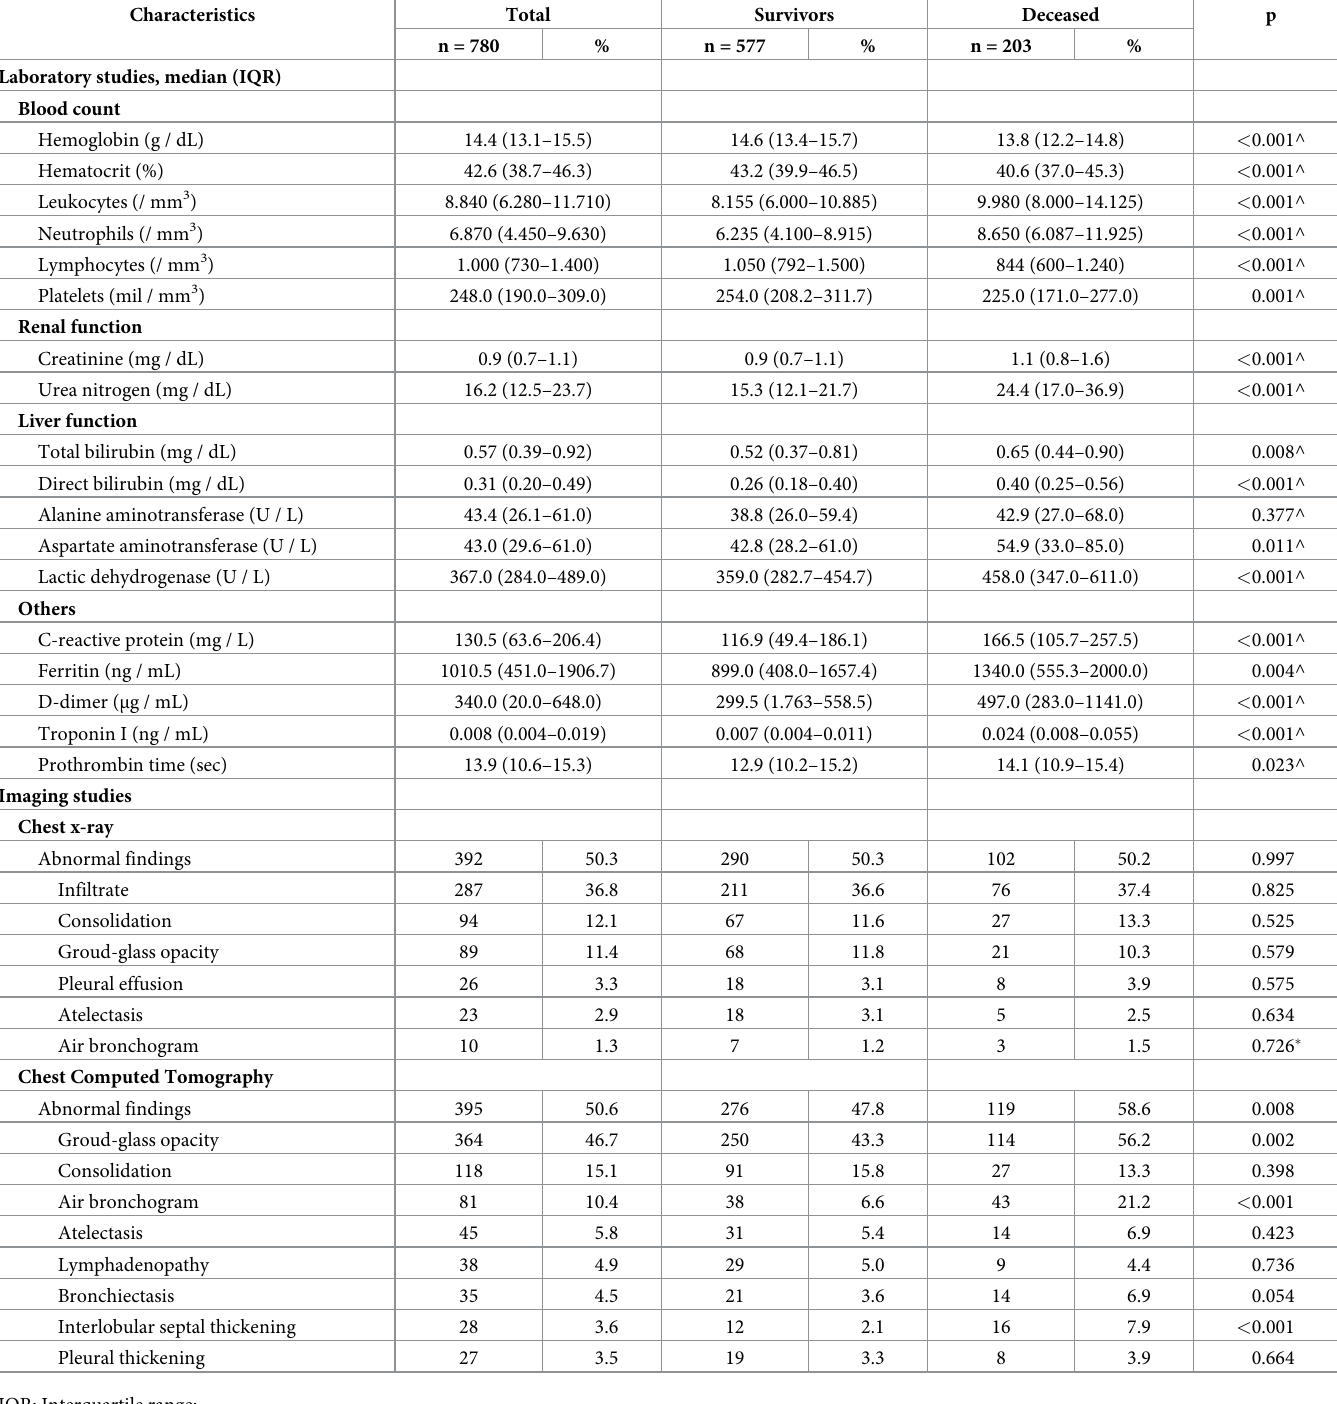
Table 2. Laboratory and imaging studies at the time of initial care among patients who survived and died, infected by SARS-CoV-2.